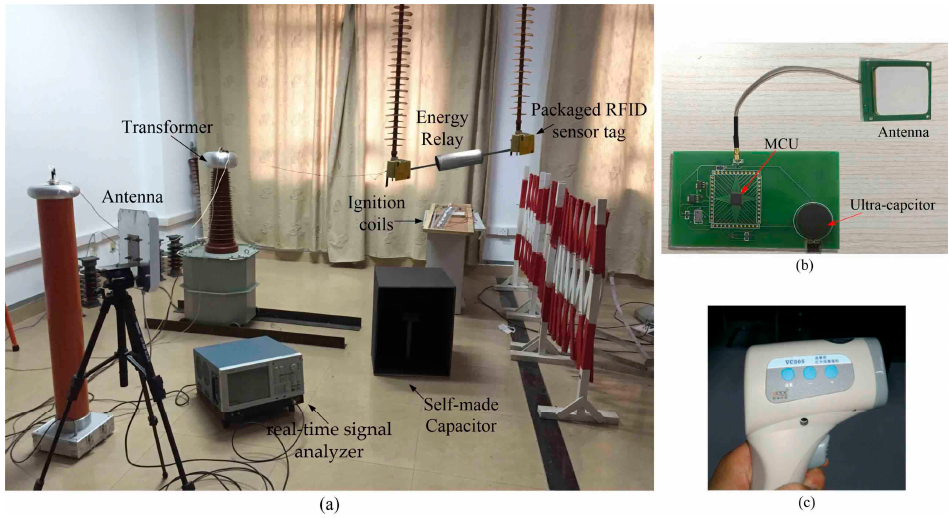
Figure 11. Testing environment: ( a ) Experimental scene; ( b ) Photo of the energy transmitter; ( c ) Far-infrared temperature instrument.